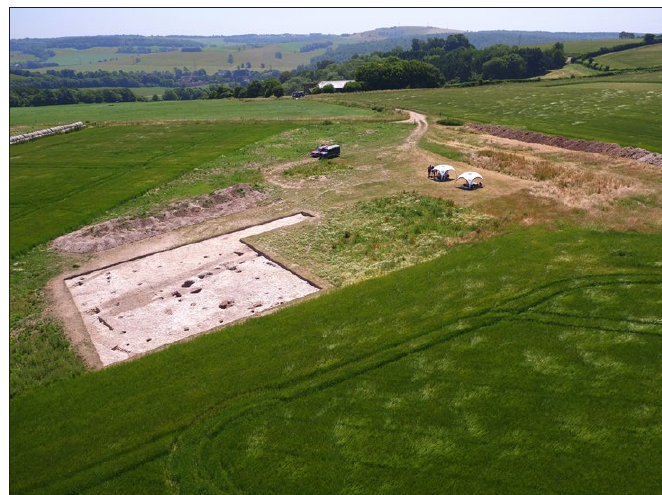
Figure 7: Looking SE across the site in 2018, towards the Trundle hill fort on the horizon. The mown area under the tents is the most likely location of the main house and will be excavated in 2019. Photo: MBR.